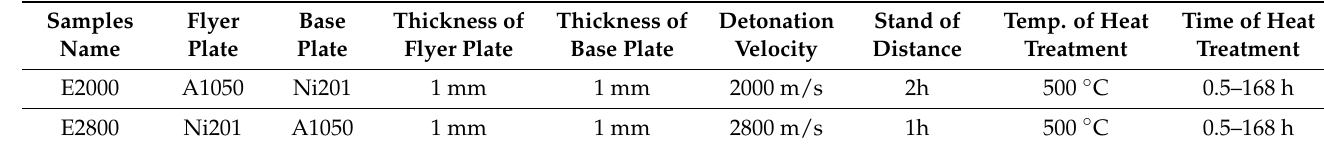
Table 2. Parameters of the explosive welding process.